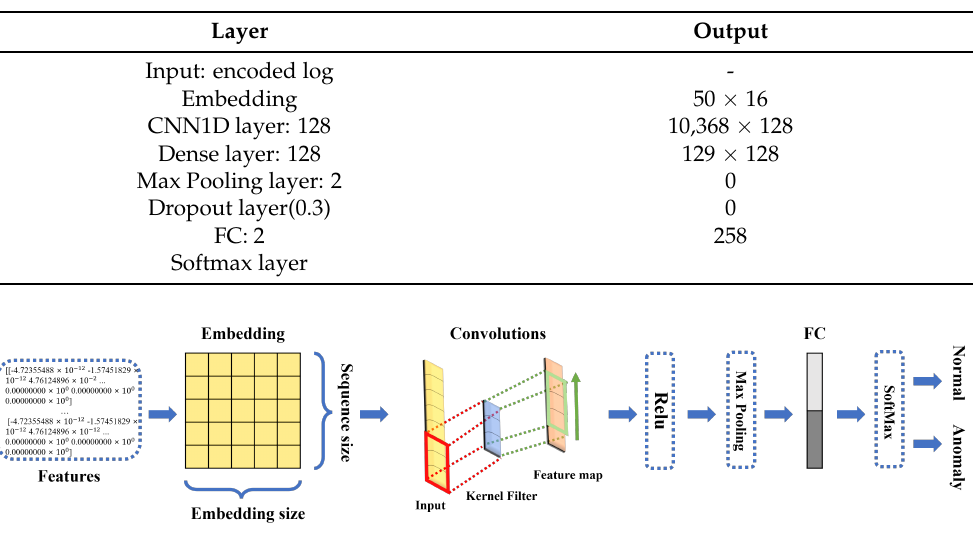
Figure 3. CNN1D-based log anomaly detection model architecture.